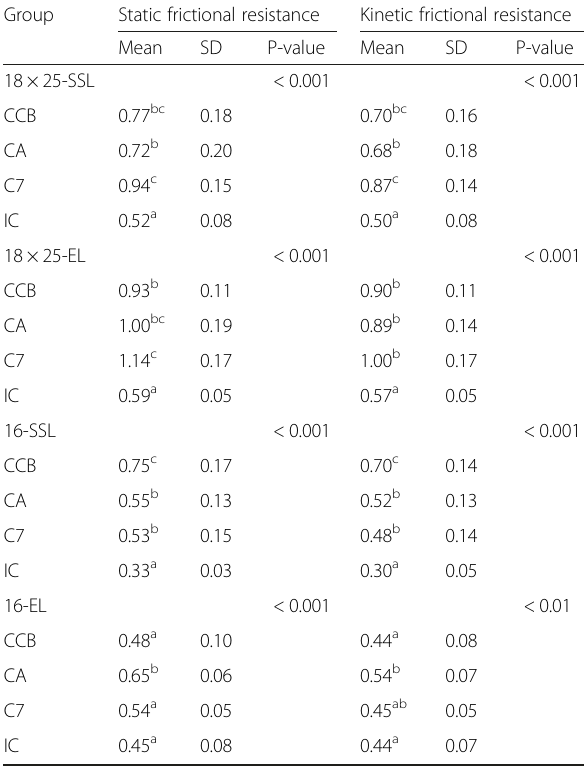
Table 2 One-way ANOVA comparing different group static and kinetic frictional resistance in Newton Group Static frictional